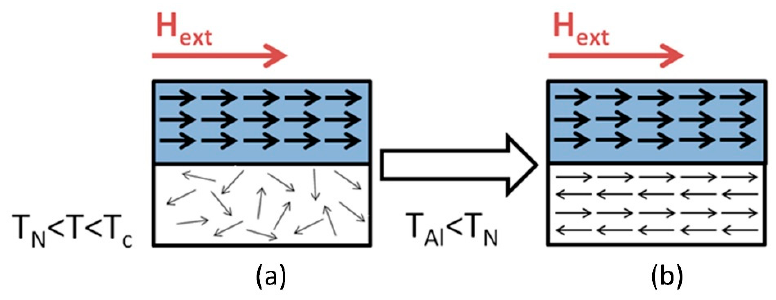
Figure 5. ( a ) Paramagnetic behavior of the AFM. ( b ) Reaching the alignment temperature.